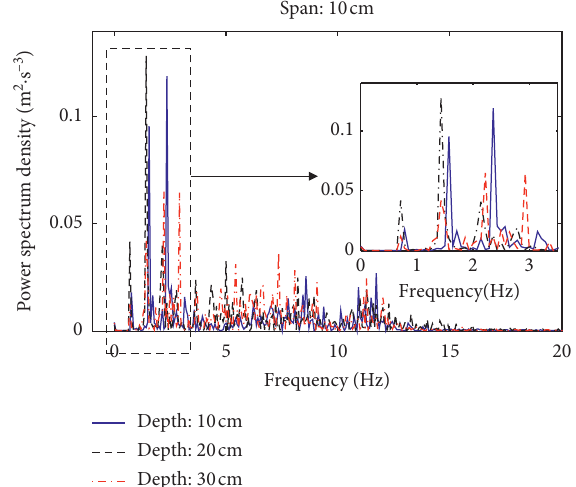
Figure 7: Frequency domain diagram of the vibration acceleration